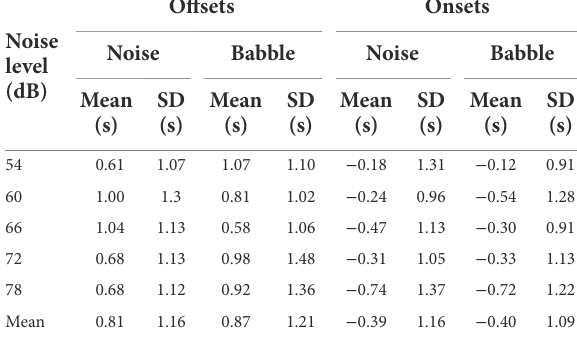
TABLE 1 Mean and standard deviations for associated HM delays (seconds) relative to nearest speech onsets and offsets for non- overlapping